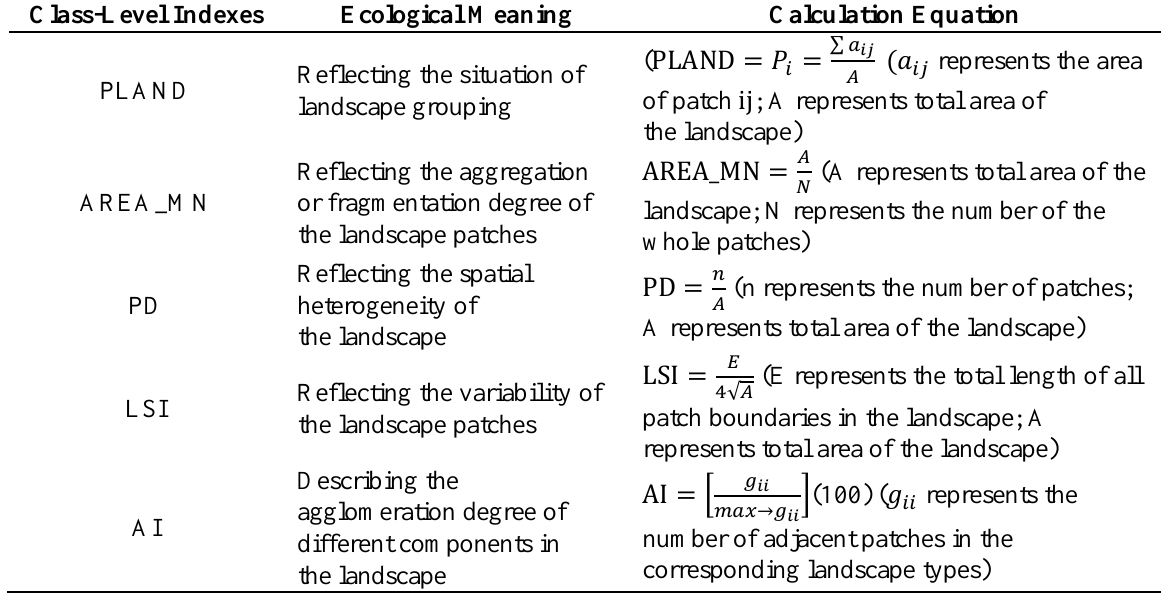
Figure 2. Land cover map from 1990 to 2010 in Nanjing: ( a ) 1990; ( b ) 2000; ( c ) 2010. Table 1. Specific ecological meanings and calculation of class-level